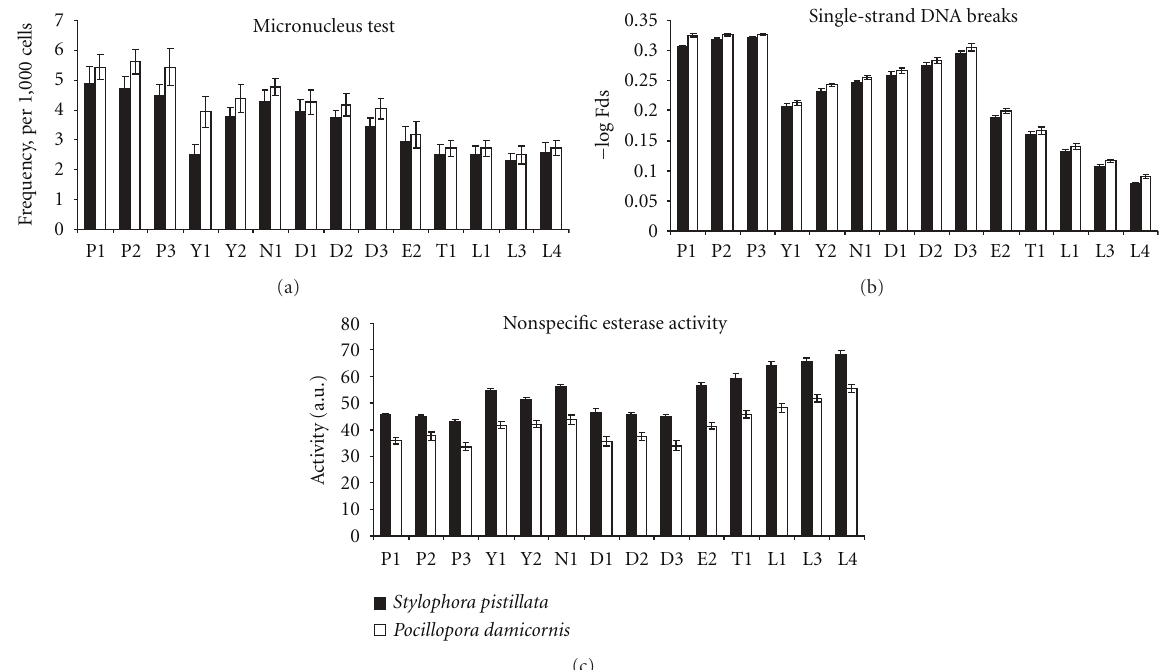
Figure 2: The results of the cytological test obtained from the two coral species at the fourteen young coral communities study stations. Micronucleus test (frequencies of micronuclei-containing cells, ‰), n = 9000 cells per sampling site. Frequencies of single-stranded DNA breaks ( − log Fds), n = 120 cells per sampling site (samples stained with Acridine orange). Esterase activities (arbitrary units), n = 120 cells per sampling site. Bars are 95% confidence interval. Stations are Peace Lagoon, southern breakwater (P1); Peace Lagoon, end of